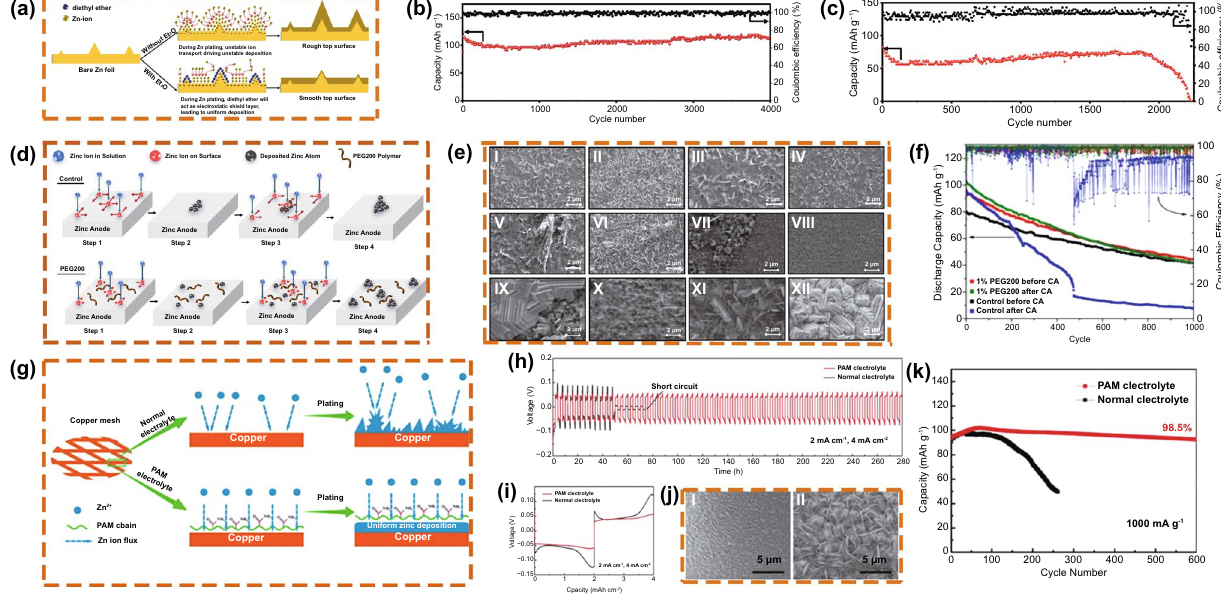
Fig. 15 a Schematic diagram of the morphological evolution for Zn anodes in a mild aqueous electrolyte with and without Et 2 O additive dur- ing Zn stripping/plating cycling. Long-term cycling performance of Zn-MnO 2 cell at 5 A g −1 b with Et 2 O additive and c without Et 2 O additive. Copyright 2019 Elsevier [71]. d Schematic diagram of the step-by-step Zn reduction and deposition process in control and PEG200 electrolytes under negative potential bias on the Zn electrode. e SEM image of Zn electrodes after exposure to 1 h CA at -135 mV overpotential vs. open- circuit voltage (OCV) under different conditions. f Cycling performance of a small rechargeable hybrid aqueous battery under 4 C before and after exposure to CA for 3 h at -135 mV overpotential vs. OCV. Copyright 2018 Wiley-VCH [114]. g Schematic illustration of Zn deposition on a Cu mesh in normal and PAM-added electrolytes. h Cycling performance in symmetrical cells and i the corresponding voltage profiles in the 10th cycle at 2 mA cm −2 for 4 mAh cm −2 . j SEM images of a 3D Zn anode using (I) PAM electrolyte and (II) normal electrolyte after 10 cycles. k Cycling performance comparison of the Zn-MnO 2 full cells using a 3D dendrite-free Zn anode and different electrolytes at 1000 mA g −1